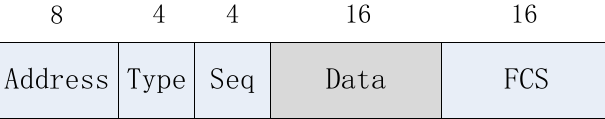
Figure 3. Structure of interrupt ack